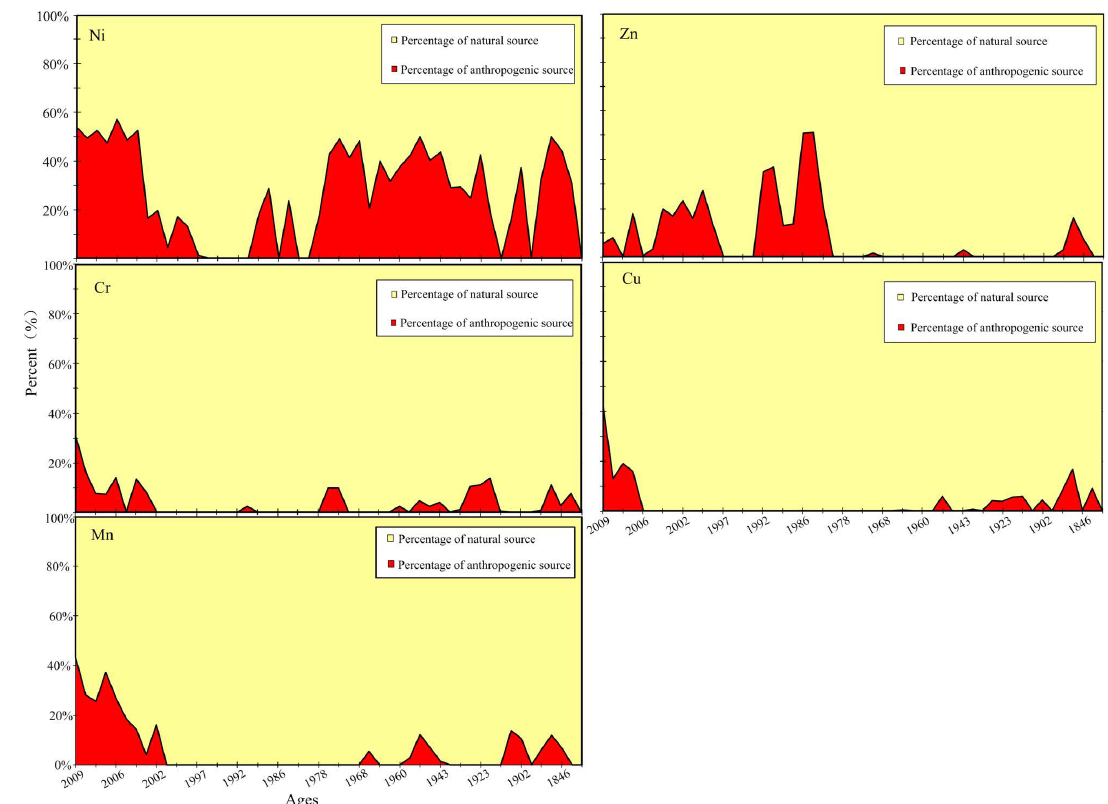
Figure 4. Natural and anthropogenic contributions to the trace metals in Lugu Lake